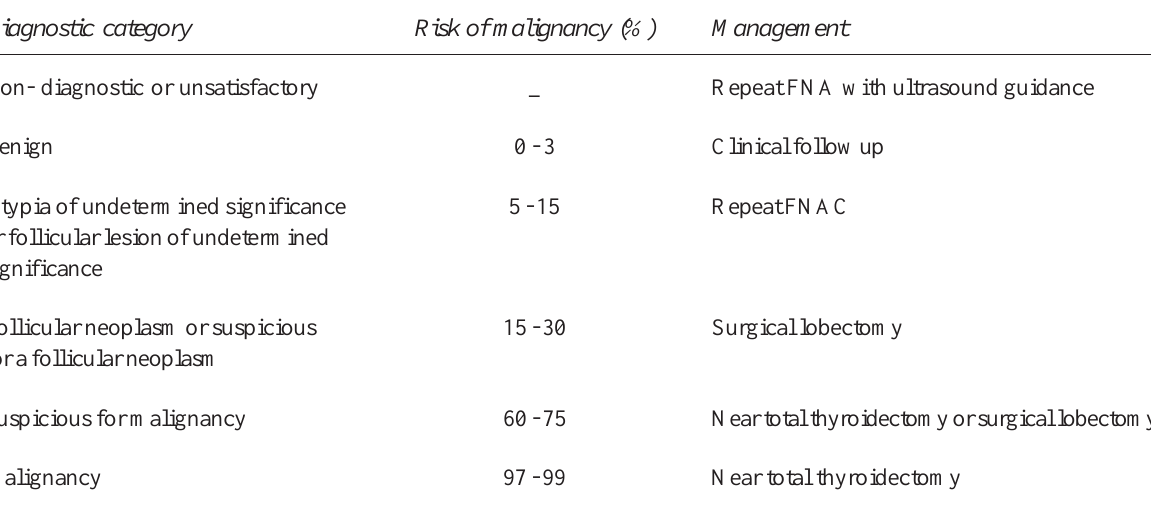
Table 3. Risk of malignancy in the BSRTC